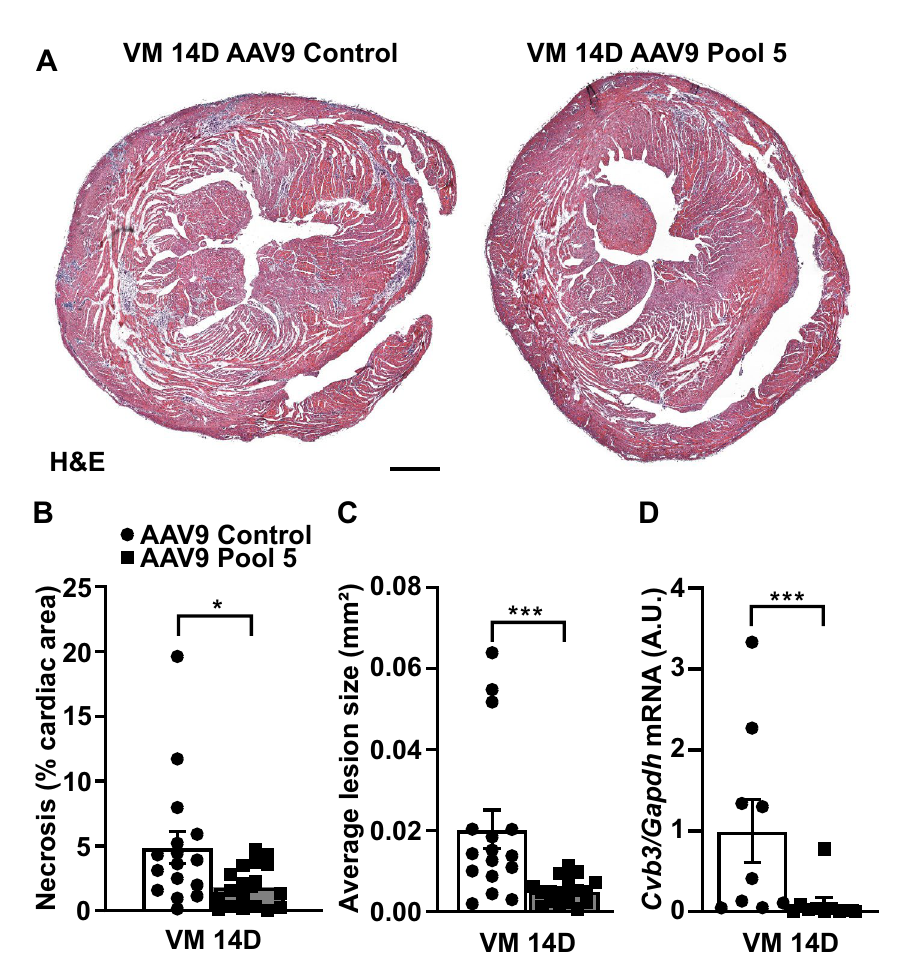
Figure 2. Synergic overexpression of the top listed cytokines (Pool 5) decreases cardiac necrosis in VM. ( A , B ) Cardiac necrosis and ( C ) average lesion size detected by hematoxylin and eosin detected by hematoxylin and eosin (H&E) staining 14 days after CVB3 infection in Pool 5-overexpressing hearts and controls. Scale bar = 500 µm. Significance assessed by Mann–Whitney U test with *p ≤ 0.05; ***p ≤ 0.001. ( D ) Relative Cvb3 viral genome expression levels at 14 days post-infection in Pool 5-overexpressing hearts and controls. Significance assessed by Mann–Whitney U test with ***p ≤ 0.001. All values are expressed as mean ±